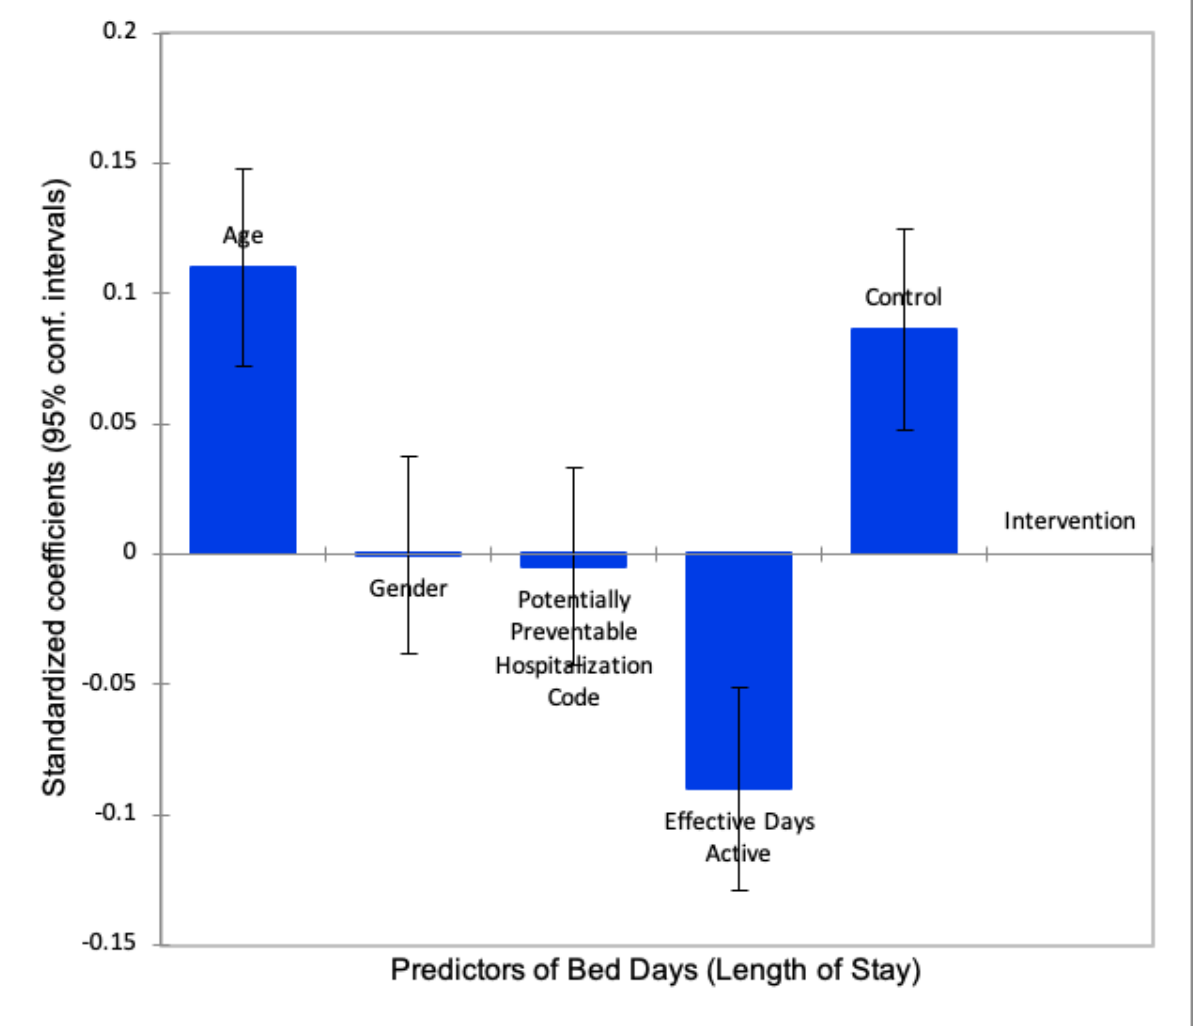
Figure 4. Bed days standardized coefficients based upon